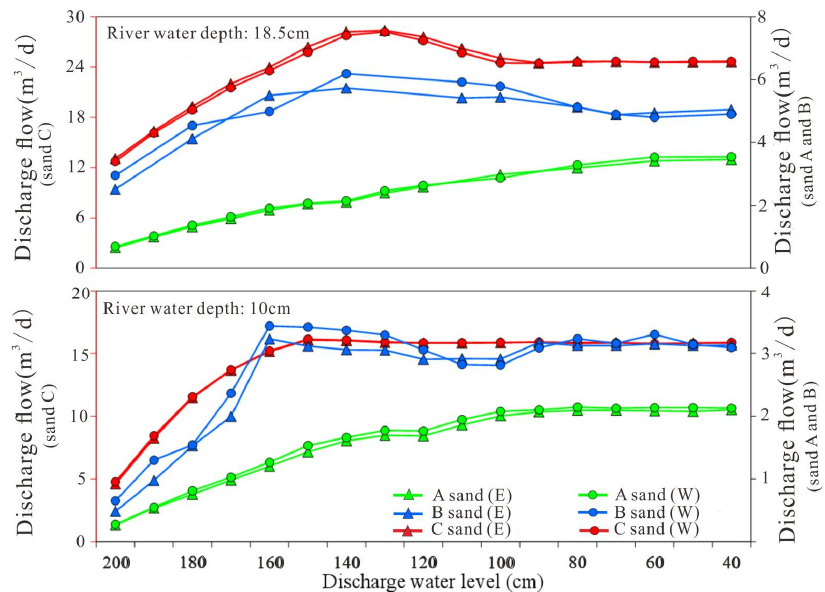
Figure 12. The relationship between discharged flow of different water-bearing media, discharged water level, and river water depth. water level, and river water